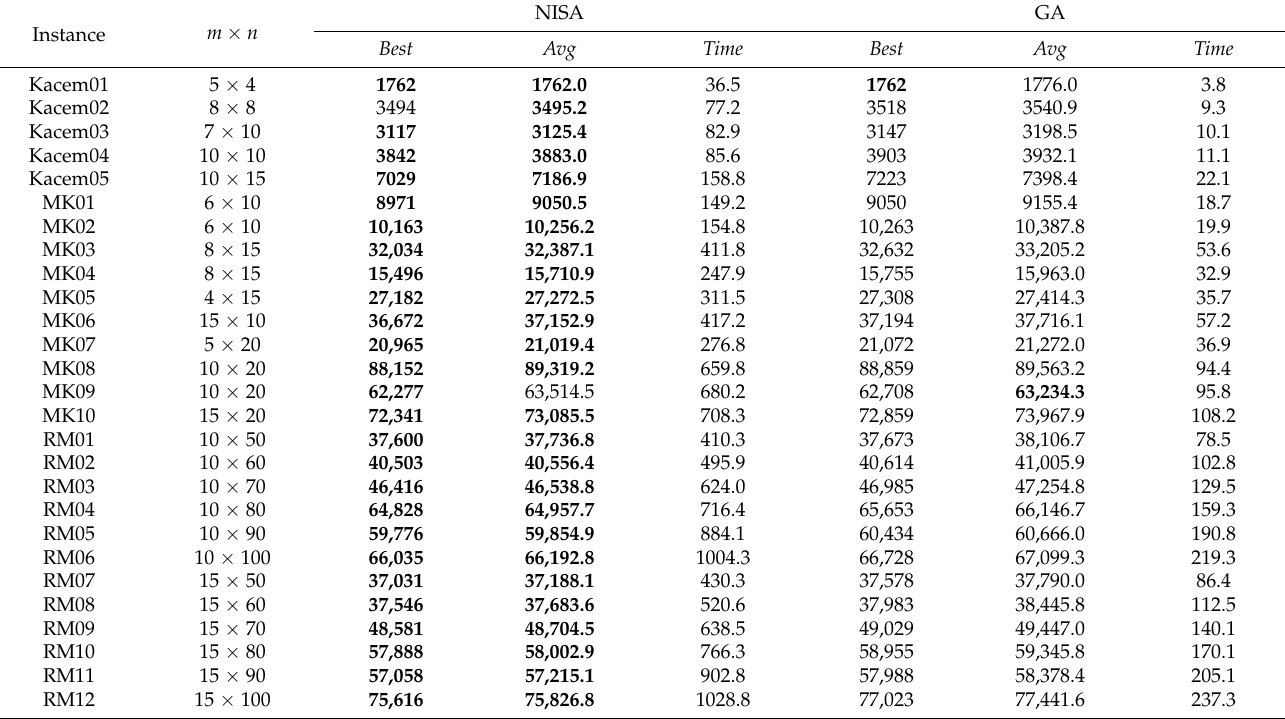
Table 7. Comparison results of NISA and existing